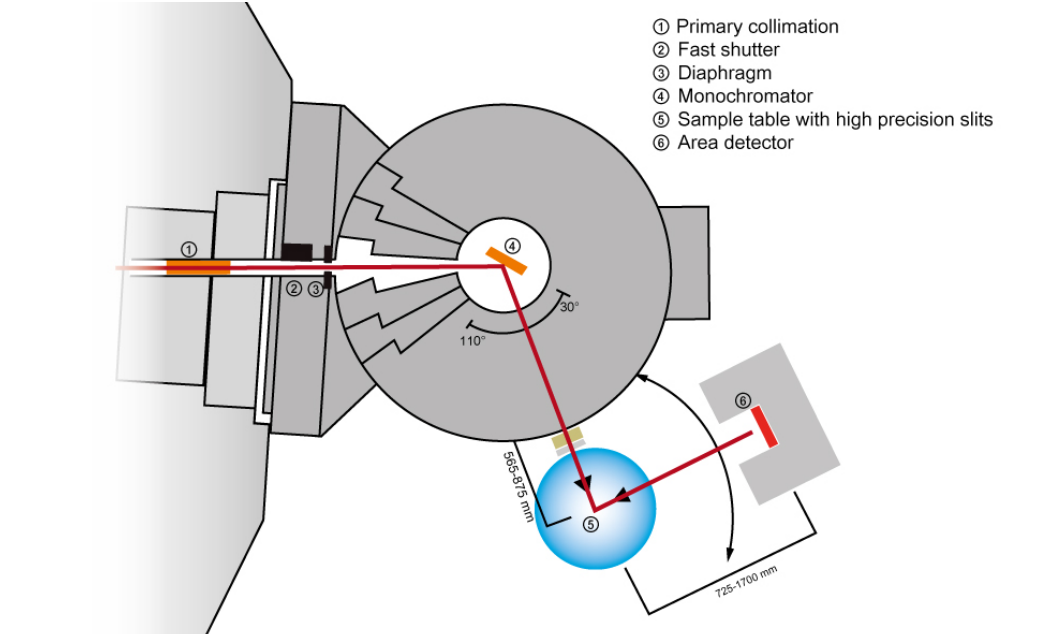
Figure 3: Schematic drawing of